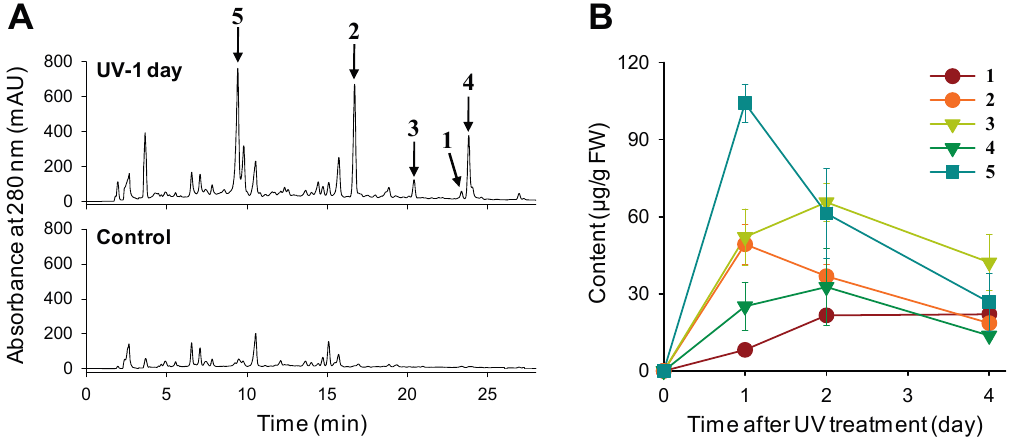
Figure 1. UV-Induced accumulation of phenolic compounds in rice leaves. ( A ) HPLC-UV (280 nm) analysis of phenolic-enriched fractions extracted from rice leaves collected at 1 day after UV treatment and untreated control. Phenolic compounds induced in UV-treated rice leaves were designated as 1 – 5 . ( B ) Contents of phenolic compounds in rice leaves collected at 1, 2 and 4 days after UV treatment. FW; fresh